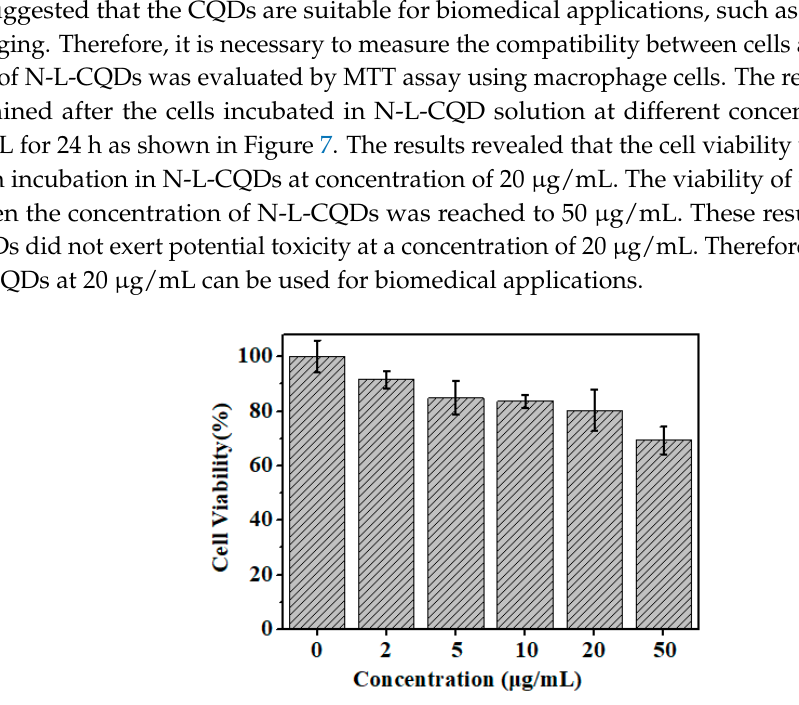
Figure 7. Cytotoxicity of N-L-CQD against mouse macrophage cells at different concentrations from 0 to 50 μ g/mL.